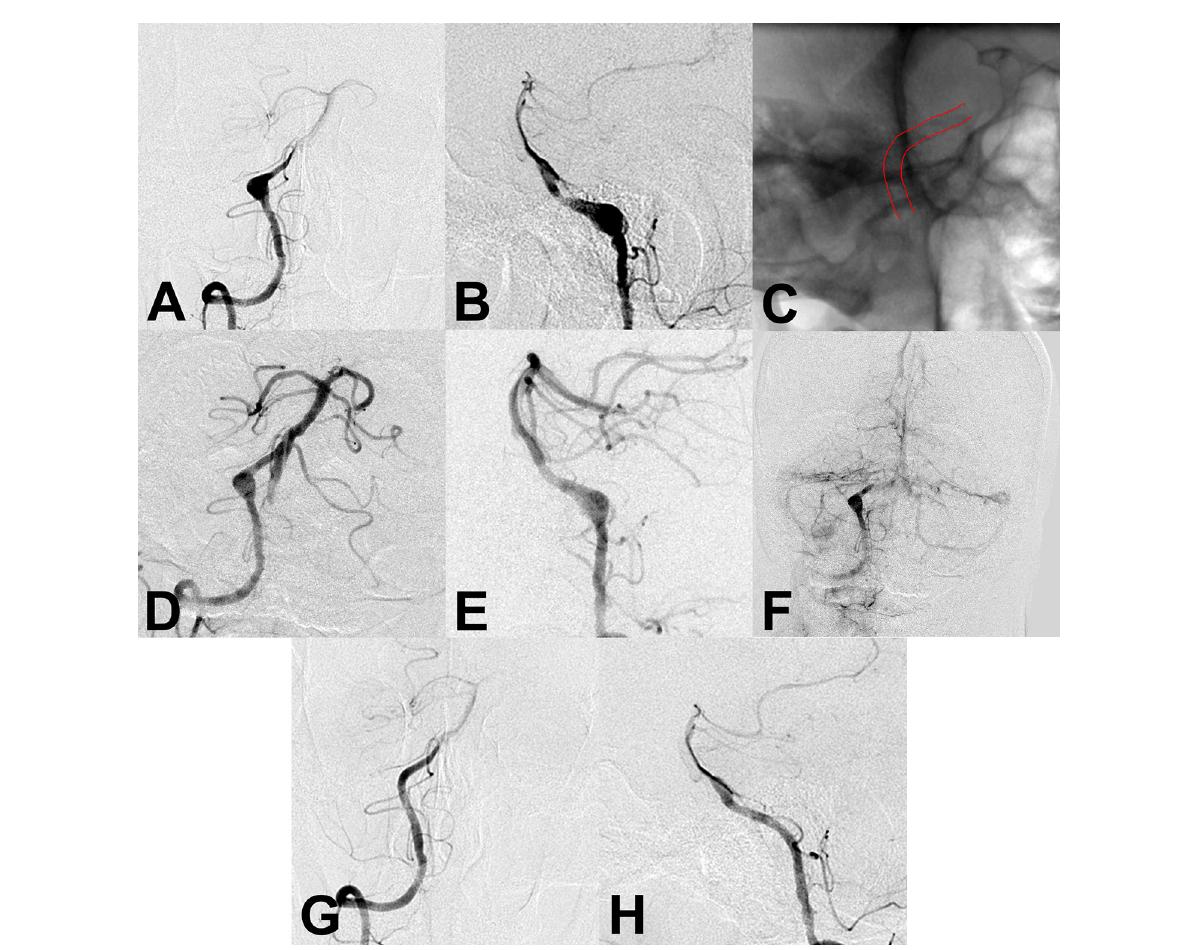
FIGURE2 (A,B) Preoperative angiography showed an unruptured vertebral artery fusiform aneurysm. (C) Intraoperative angiography showed successful deployment of a flow diverter stent (lines). (D–F) Angiography immediately after the procedure showed a residual aneurysm with significant stasis. (G,H) Follow-up angiography 6 months after the procedure showed complete aneurysm